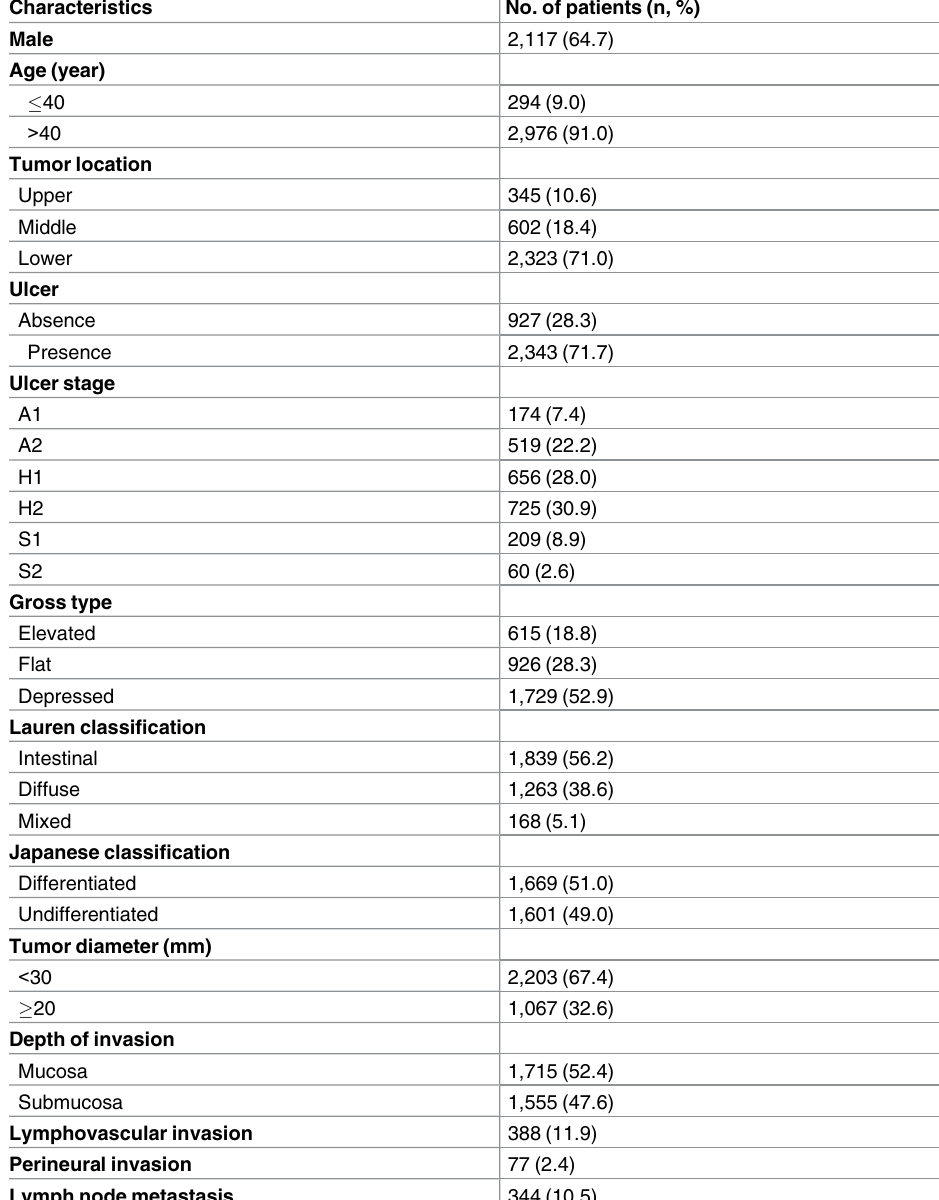
Table 1. The Clinicopathologic Characteristics of the Subjects (n = 3,270).